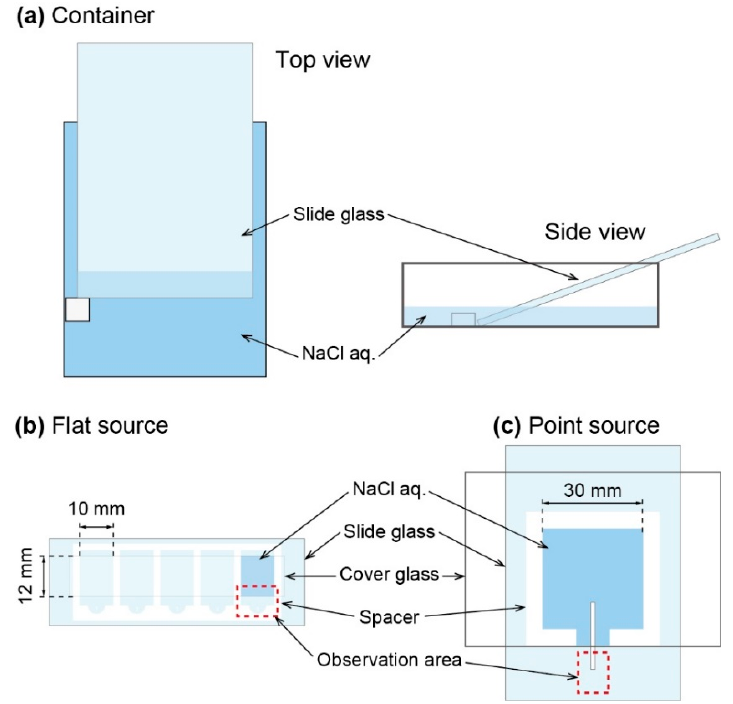
Figure 1. Illustration of experimental setup. ( a ) Edge of a slide glass was soaked into NaCl aqueous solution (5.4 M). ( b ) An aqueous solution of NaCl (2.0–5.4 M) was added in thin space between a slide glass and a cover glass, whose gap was 0.07 mm. ( c ) An aqueous solution of NaCl (2.0–5.0 M) was put on a slide glass with silicon sheet (thickness: 0.5 mm). Elongated filter paper (width: 2 mm) was put on the glass. Aqueous solution was covered with another slide